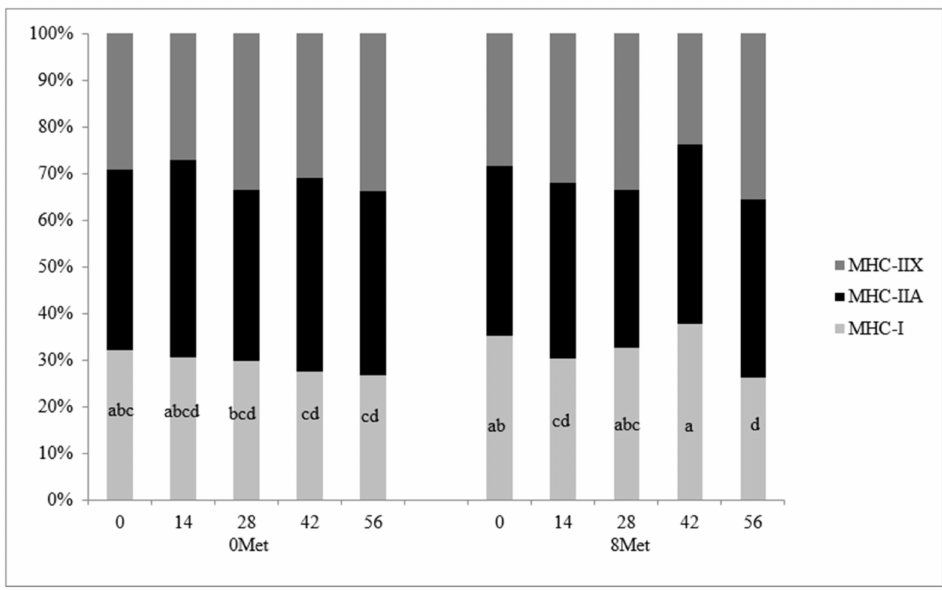
Figure 1. The distribution of skeletal muscle fiber types classified by myosin heavy chain (MHC) isoform in bovine longissimus tissue biopsy samples collected on d 0, 14, 28, 42, and 56 of the feeding trial ( n = 20). Treatments were 0MET (0 g of encapsulated methionine and 4 g of encapsulated lysine per head per d) and 8MET (8 g of encapsulated methionine and 4 g of encapsulated lysine per head per d). Cross-sections of skeletal muscle samples were stained by immunohistochemistry for the presence of MHC isoforms. Differing superscripts denote means within MHC isoform I differ for treatment by day interaction ( p =